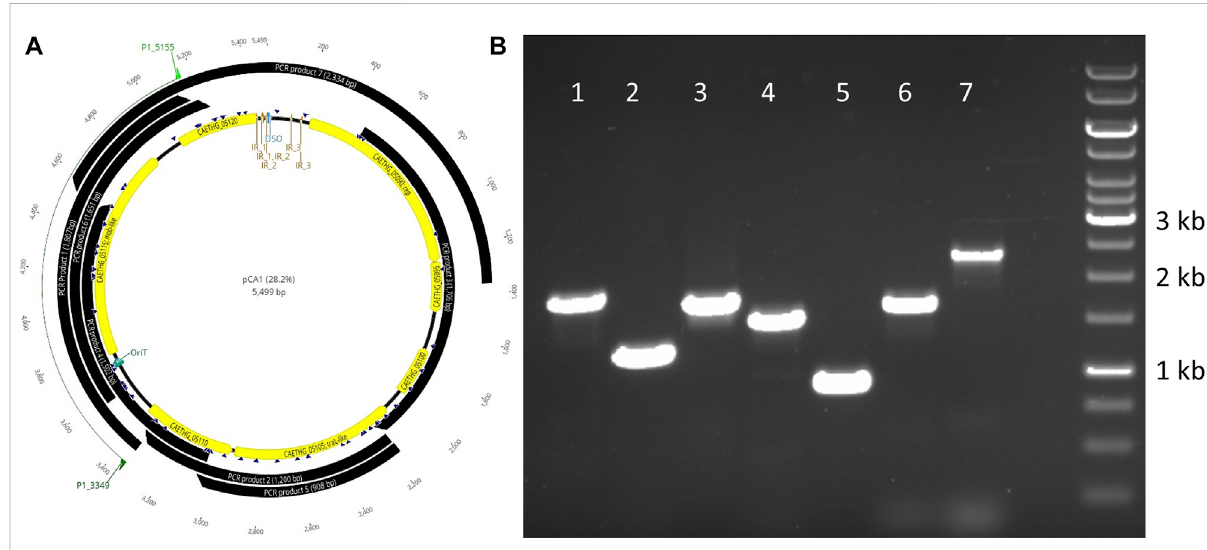
FIGURE 2 Veri fi cationoftheplasmidpCAsequence via PCRandagaroseelectrophoresis.PCRproductlocationsrelativetothegenelocationsonpCAare shown (A) and associated amplicons for respective products 1 – 7 (B)